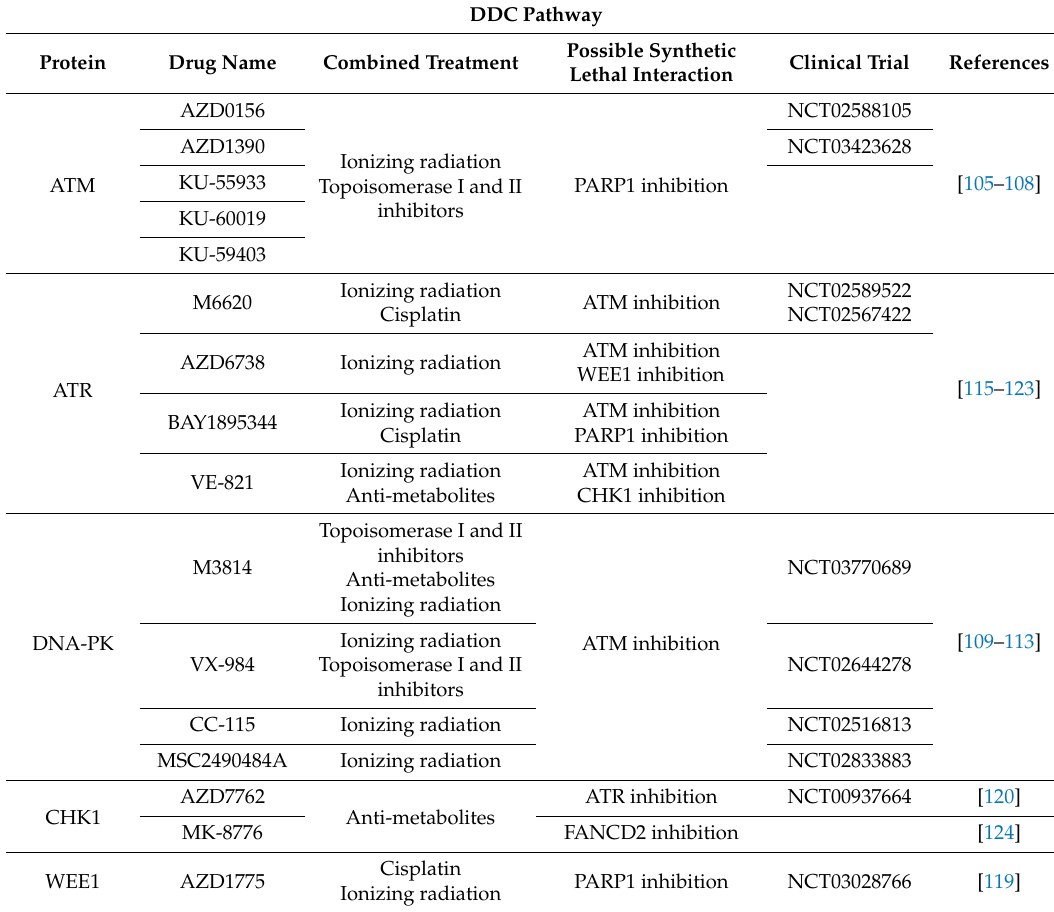
Table 1. DDC-related proteins targeted in cancer